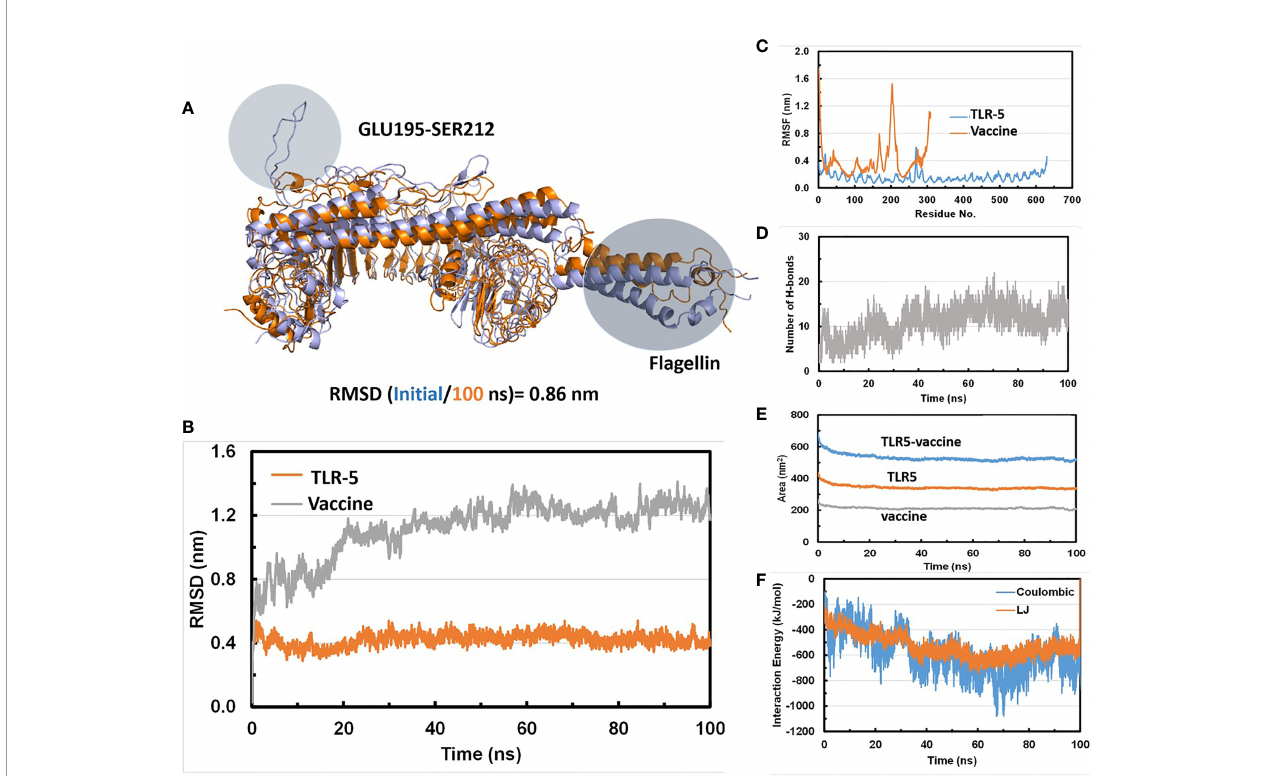
FIGURE 3 | (A) Superimposition of a snapshot obtained after 10 ns and 100ns of simulation time highlighting a high RMSD value due to fl exible loop regions and terminal region of fl agellin in a vaccine construct; (B) Time evolution of backbone RMSD of TLR-5 and vaccine construct during MD simulations; (C) Backbone RMSF plots; (D) Time evolution of number of hydrogen bonds Between TLR-5 and vaccione construct; (E) Solvent accessible surface area of TLR-5 and vaccine construct; (F) Variation in Interaction energy plot with segregated electrostatics and vanderwaals component obtained for entire simulation